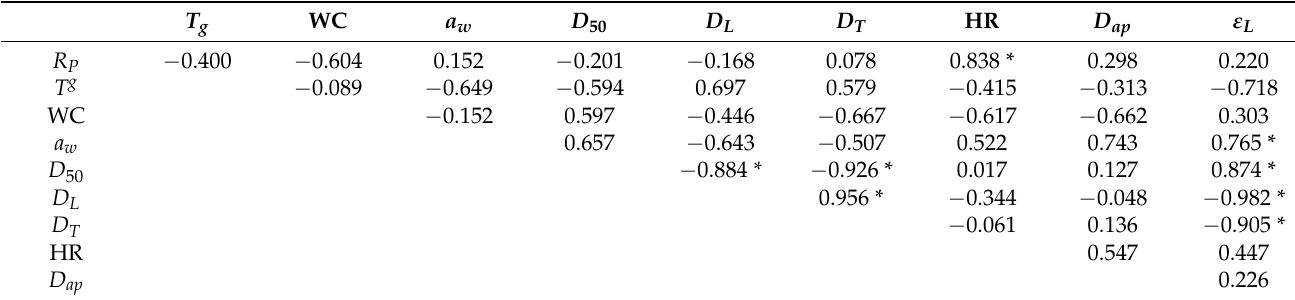
Table 3. Pearson correlation coefficients (r) between the powder recovery ( R P ), glass transition temperature ( T g ), water con- tent (WC), water activity ( a w ), median diameter ( D 50 ), bulk loose density ( D L ), bulk tapped density ( D T ), Hausner ratio (HR), apparent density ( D ap ), and loose bed porosity ( ε L ) of the beetroot powders; asterisks indicate statistically significant correlations ( p <